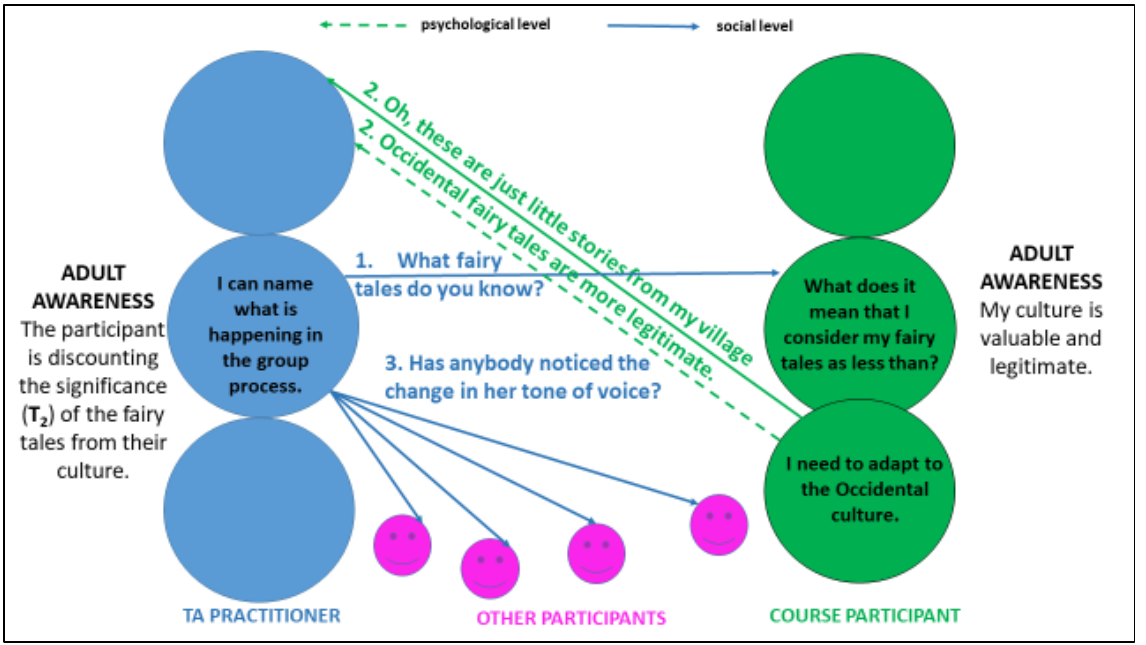
Figure 2: Naming a Transaction containing a